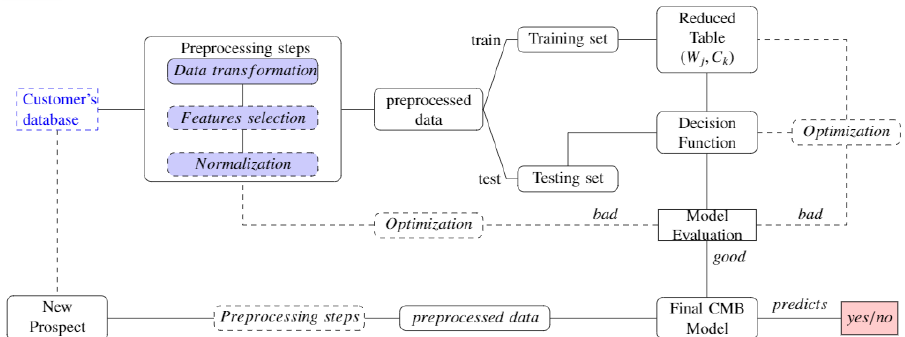
Figure 1. The global process of a predictive classification system with the CMB approach.